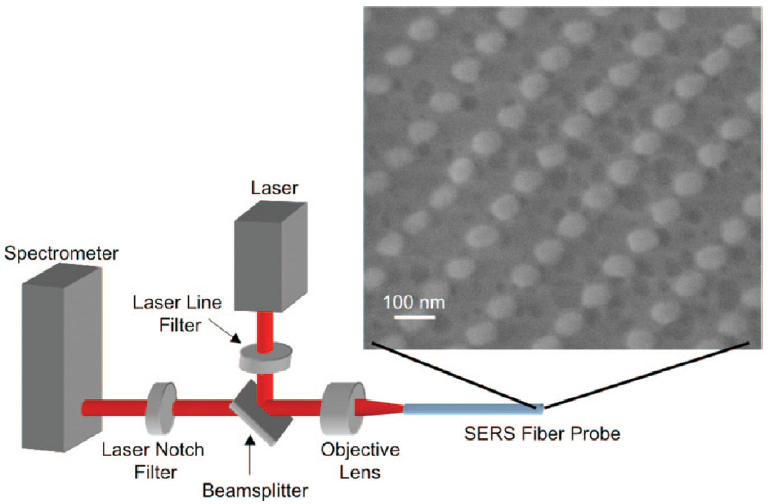
Figure 24. Schematic depiction of the configuration used to characterize the SERS fiber optic probe and a scanning electron micrograph of an array of gold optical antennas on the facet of a fiber. Reprinted with permission of [88].